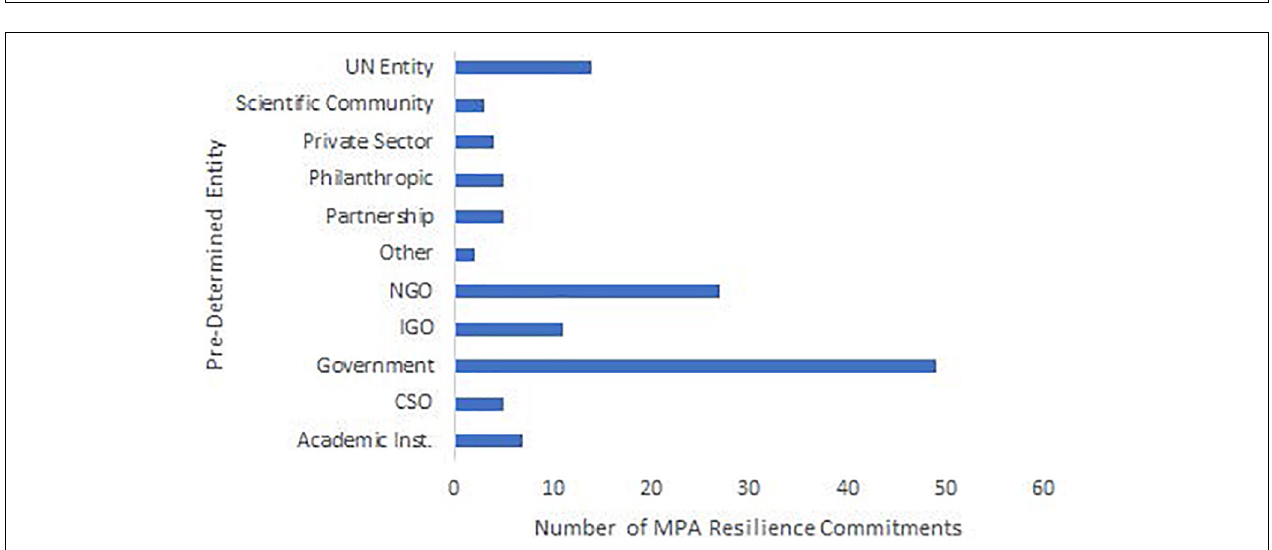
FIGURE 4 | Marine protected area commitments related to resilience. Voluntary commitments made with regards to sustainable development goal 14.5 (related to marine protected areas) which specifically mentions resilience in the descriptor (see Table 2 for definitions of resilience; Table 3 for examples of commitments). Data from https://oceanconference.un.org/commitments/ as of September 2017.